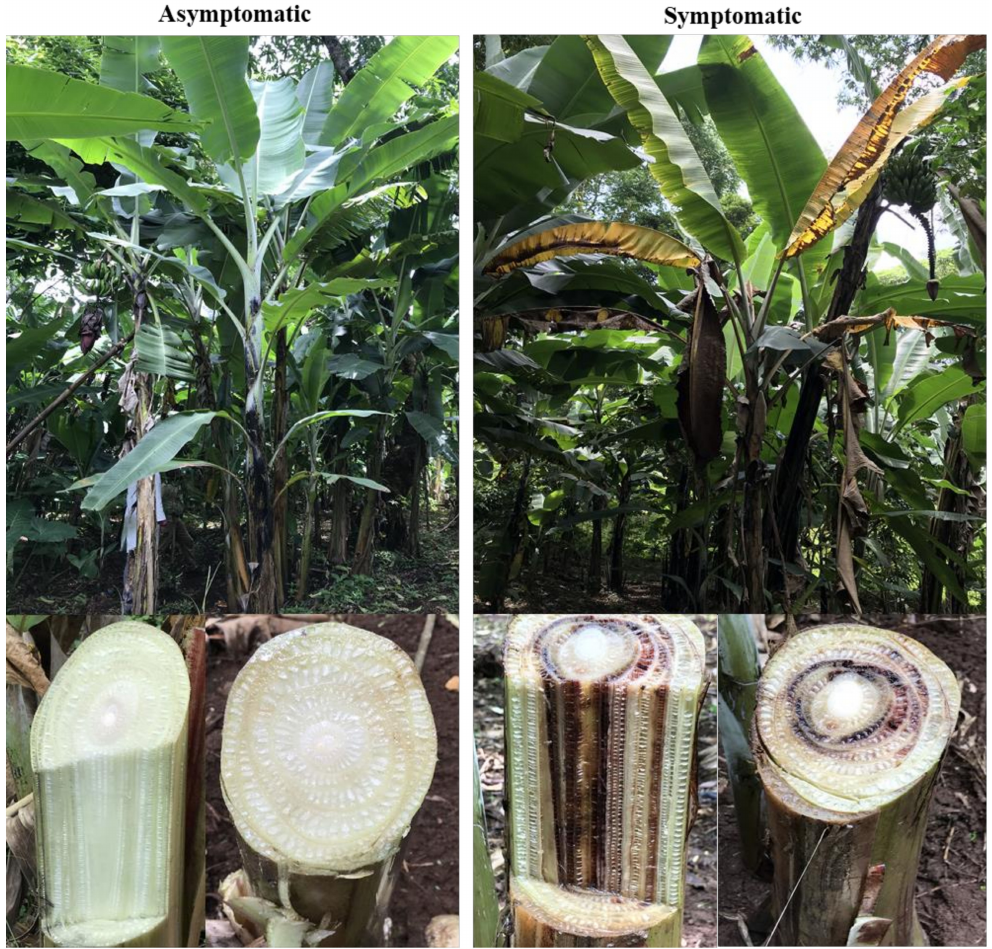
Figure 1. Banana plants under non-stressed (asymptomatic) and disease stressed conditions (symptomatic) caused by Fusarium oxysporum